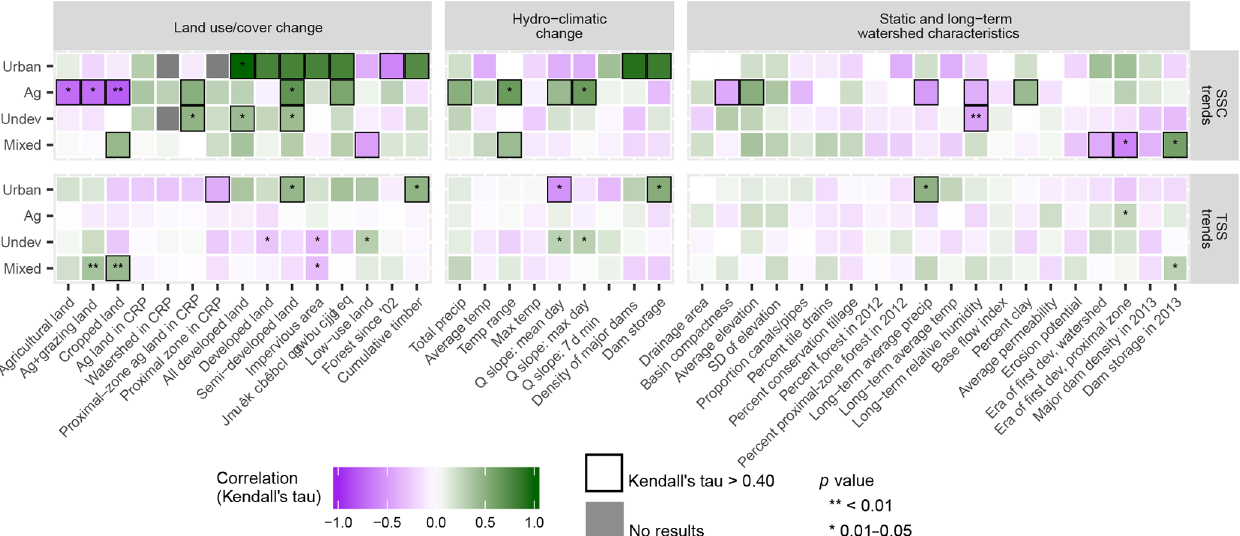
Figure 4. Correlations between 1992–2012 sediment trends and various potential drivers of change (land use/cover and hydro-climatic variables) and static/long-term watershed characteristics, grouped by the 2012 land use of the contributing watershed. Note that land use/cover change variables and hydro-climatic-change variables are correlated with sediment trends in percent change, whereas the static/long-term watershed characteristics were correlated with the sediment trends in absolute percent